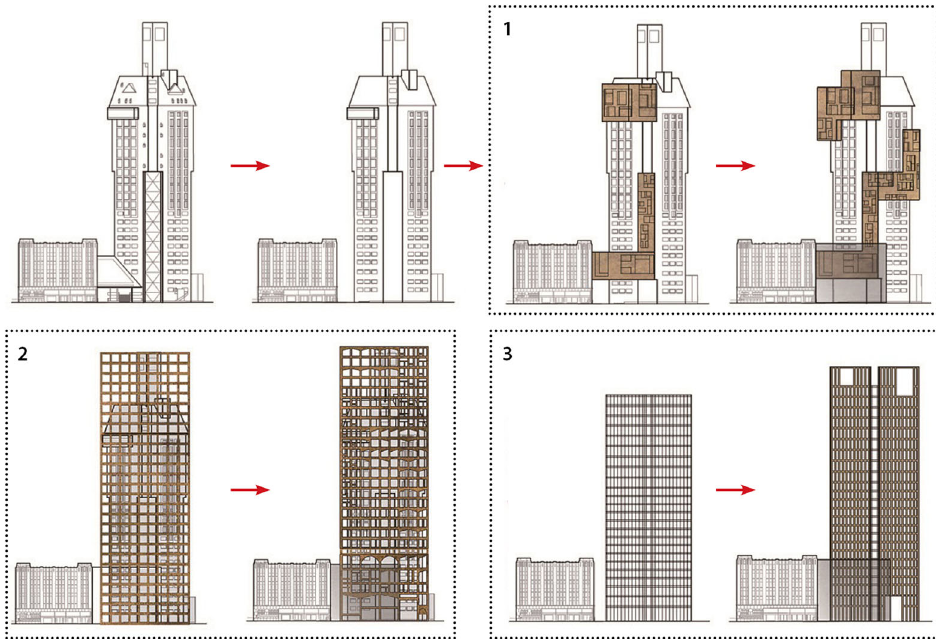
Fig. 11 Diagrams of three renovation proposals of Neri & Hu Design and Research Office (Source: Figures provided by Neri & Hu Design and Research Office)